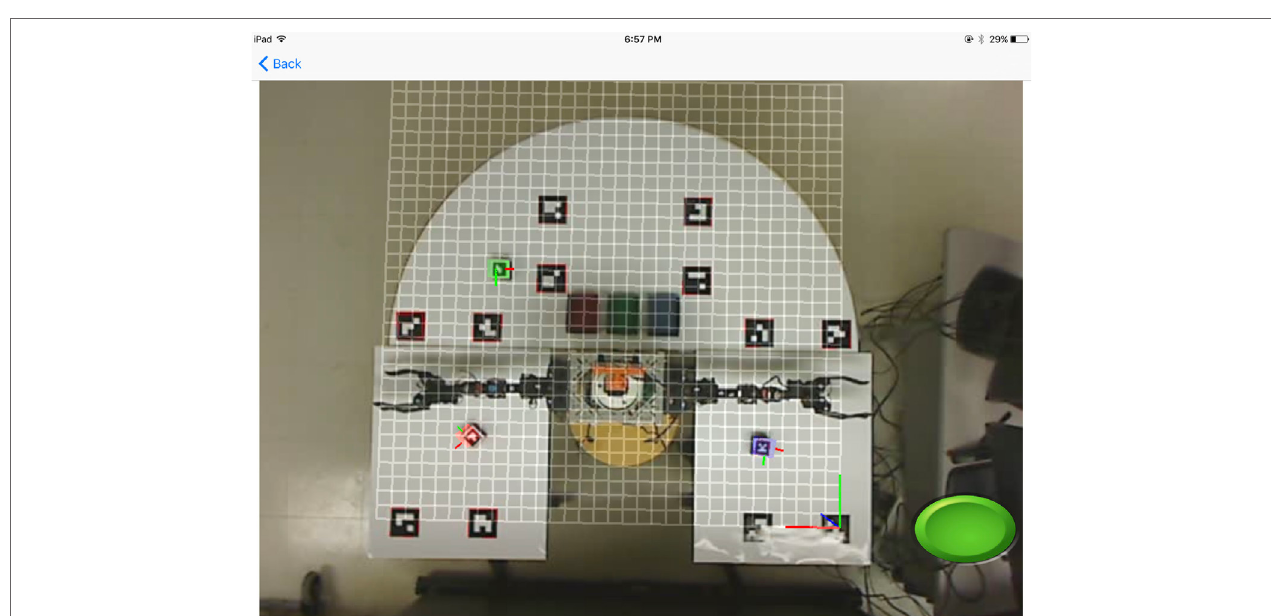
FigUre 7 | exocentric view of the workspace as captured from an overhead camera .